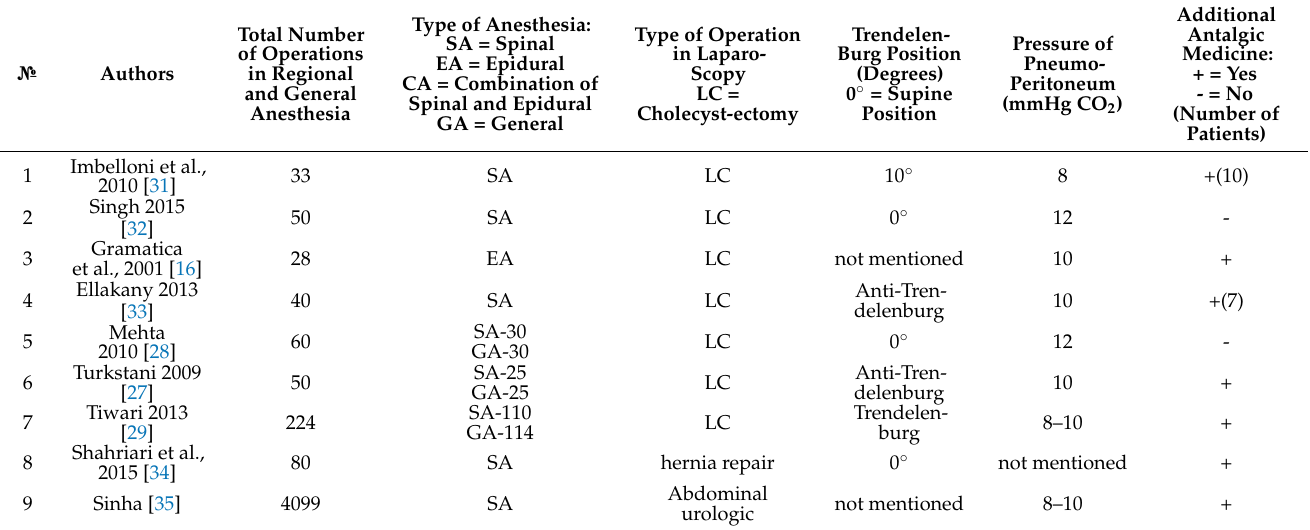
Table 1. Review of existing studies on regional anesthesia in general laparoscopic surgeries.